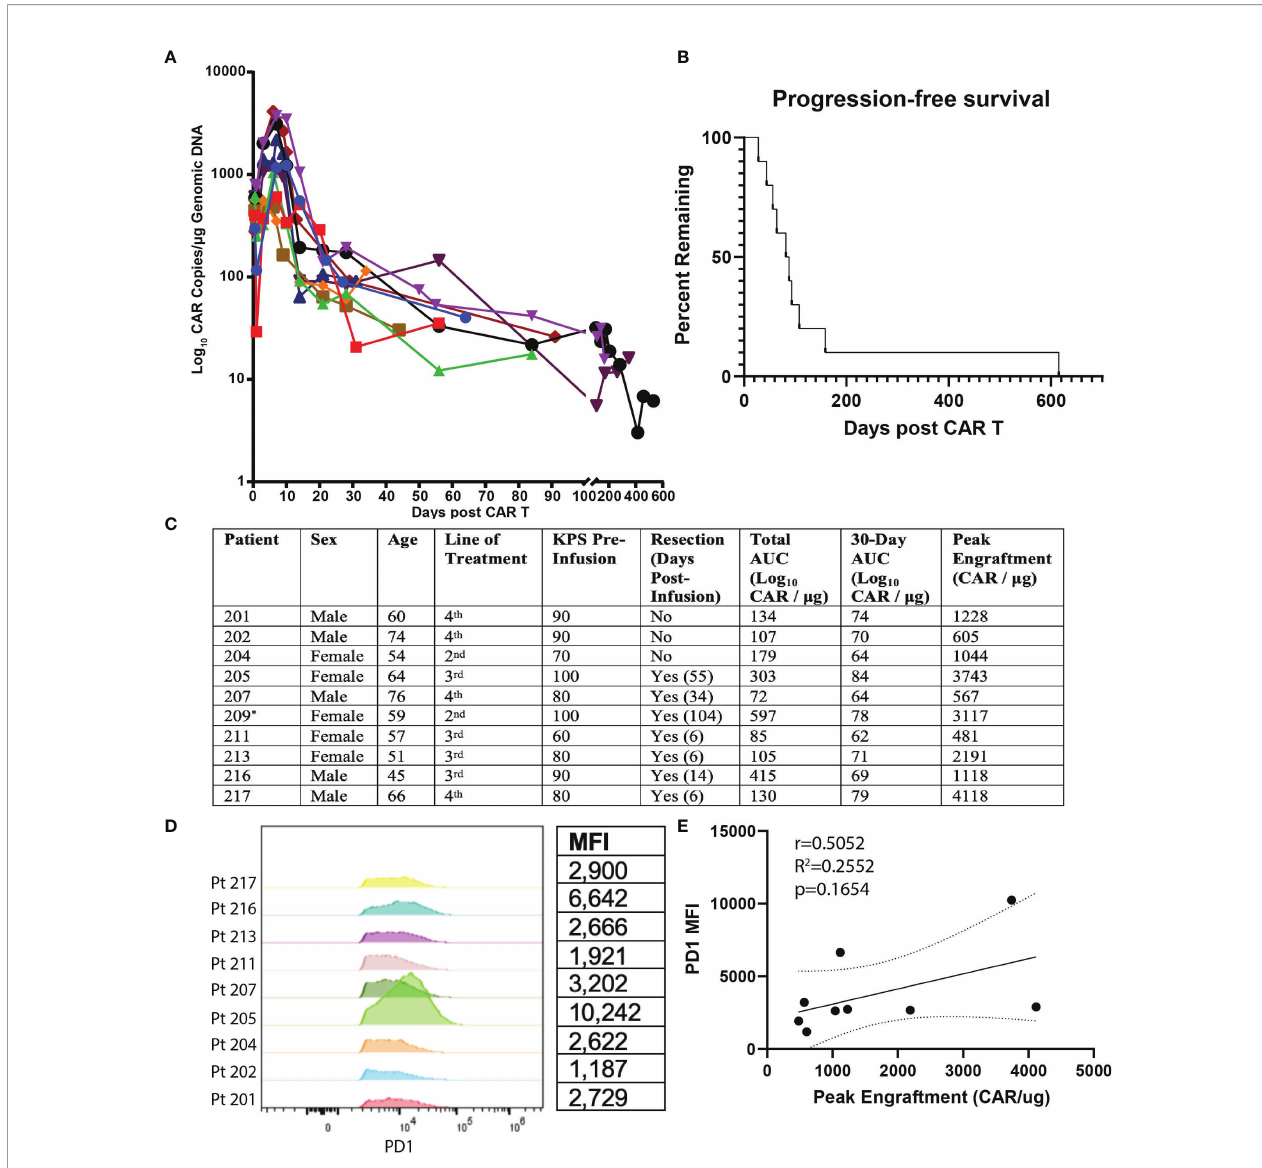
FIGURE 1 | Summary of Clinical Outcomes for EGFRvIII-Directed CAR T Clinical Trial and Flow Cytometric Analysis of Patient Plasma Products. Summary of clinical outcomes for clinical trial on EGFRvIII-directed CAR T for recurrent glioblastoma (NCT02209376). Patient 209 was ultimately not included for analysis due to having an outlier PFS value. (A) Plot of days following CAR T infusion and engraftment in peripheral blood. Following earlier studies, peripheral engraftment was quanti fi ed as log 10 copies/ m g of genomic DNA. (B) PFS plotted as Kaplan-Meier estimator for all subjects. (C) Summary values of patient characteristics, performance of resection, total AUC, 30-day AUC, and peak engraftment for all subjects. * Patient 209 was excluded due to having an outlier progression-free survival (p<0.001 on Grubbs ’ test). (D) Comparison of PD1 expression for CD3 + CD4 + CAR + cells for transfusion products from all nine recurrent GBM patients receiving EGFRvIII-directed CAR T. Mean fl uorescence intensity (MFI) is quanti fi ed on the table to the right. (E) Correlation of PD1 MFI and peak CAR T engraftment